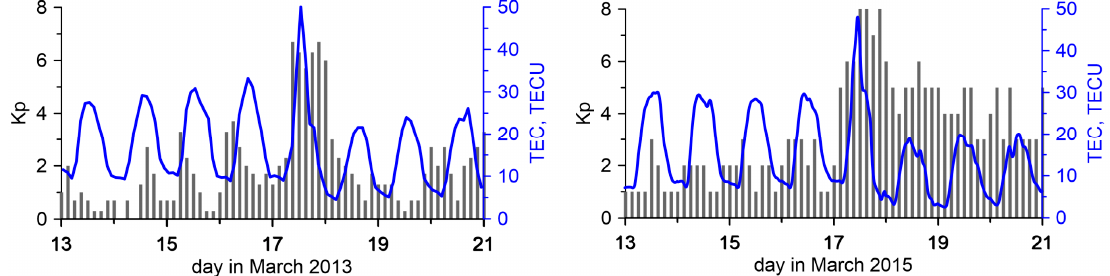
Figure 3. Planetary K index estimated for 13–20 March 2013 ( left ) and 13–20 March 2015 ( right ) and change of TEC values over central Europe during the analyzed time intervals.